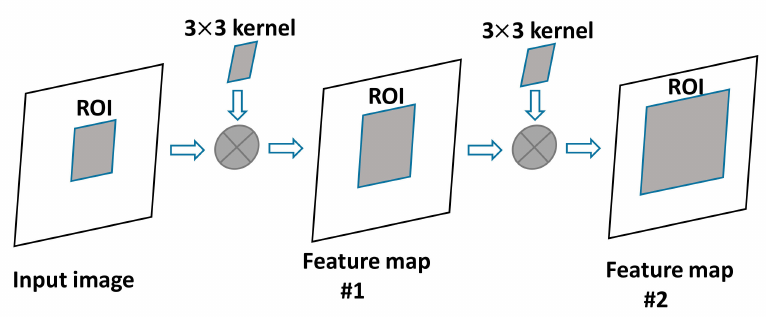
Figure 1. Region of Interest (ROI) changes without